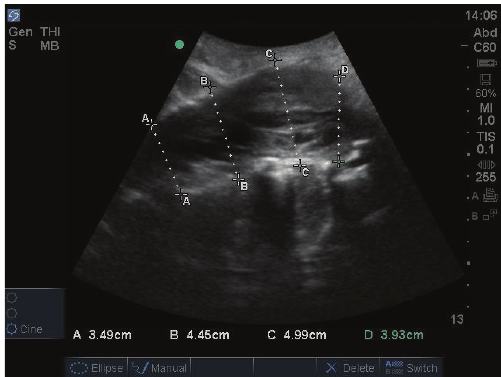
Figure 2: Abdominal ultrasonography demonstrating width mea- surements of